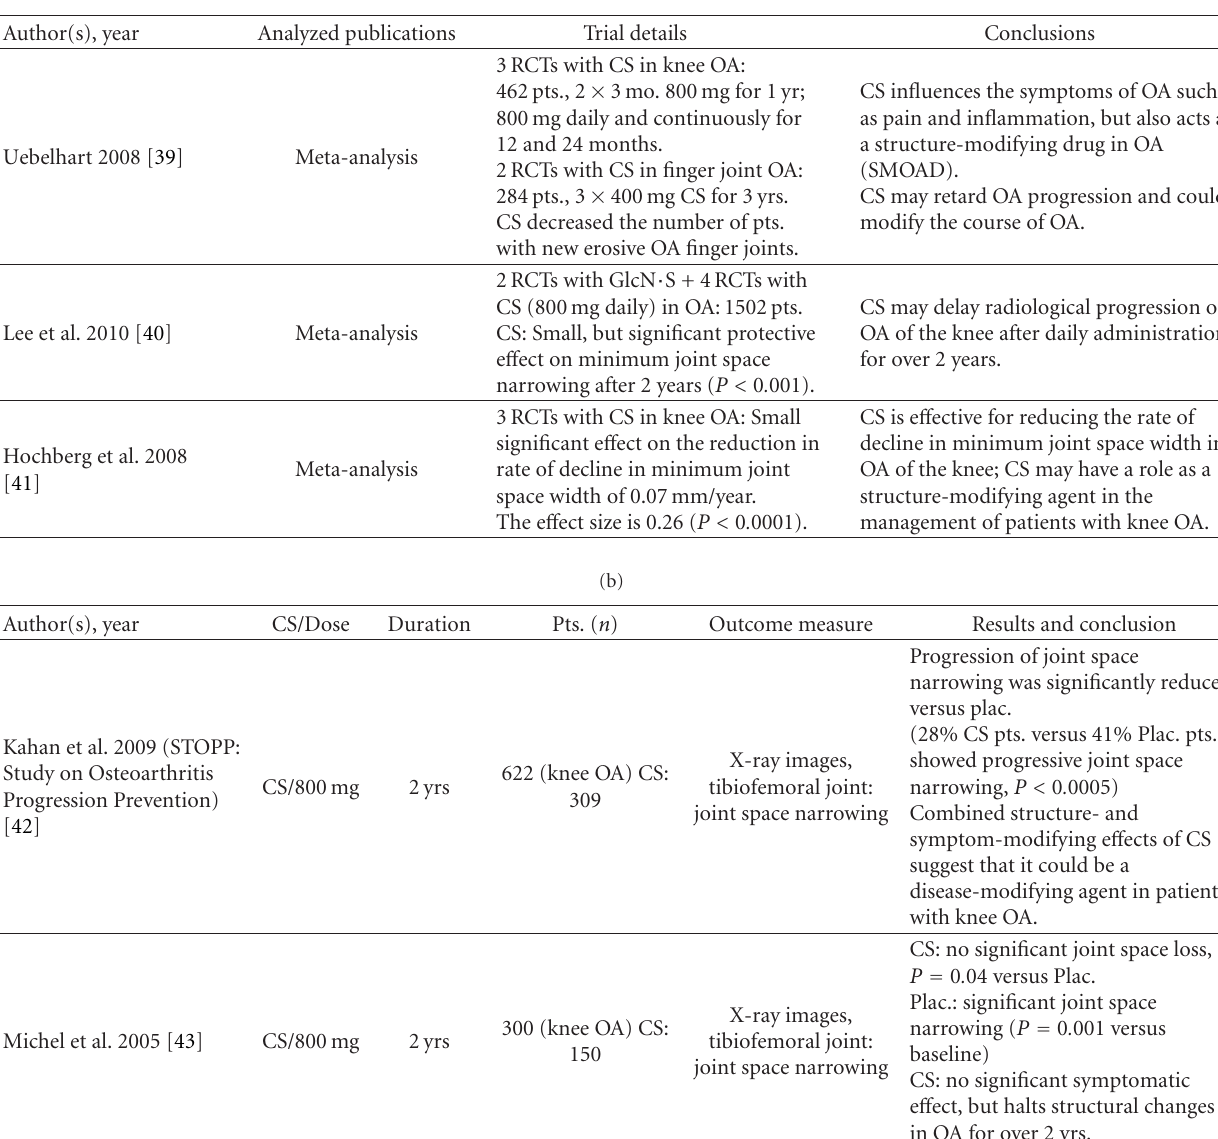
Table 3: Characteristics and results of selected meta-analyses and RCTs-chondroitin